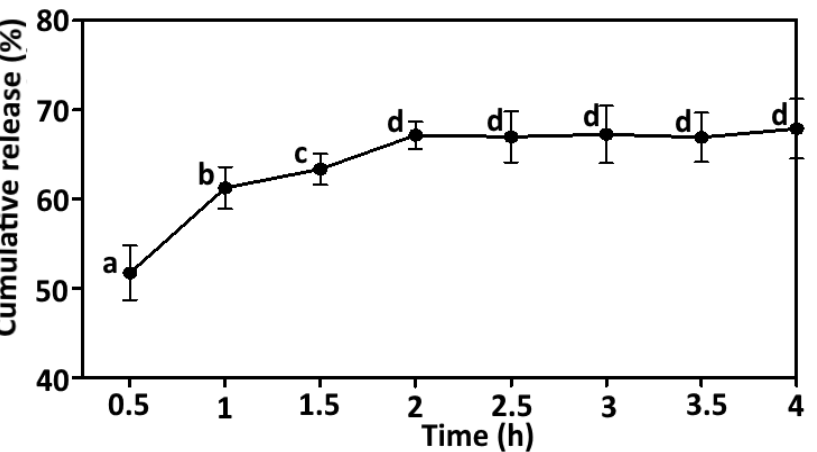
Figure 5. Cumulative release (%) of curcumin from CHBs in phosphate buffer at biological pH 7.40. Error bar represents the standard deviation of the mean determined from three independent determinations. Different lower-case alphabets (a to d) represent significant differences ( p < 0.05; Duncan’s multiple range test) over the time (0.50 to 4 h). CHBs, curcumin hydrogel beads.